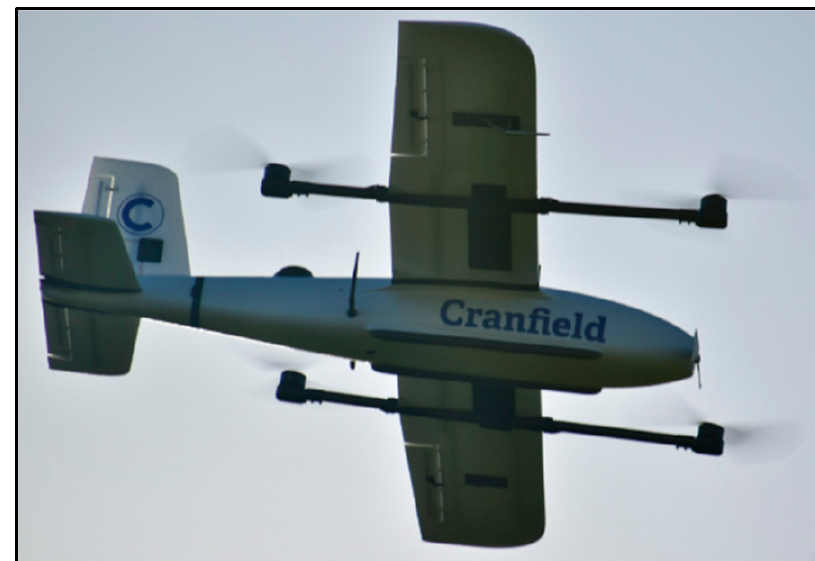
Figure 1. Image of the SWIFT aircraft in forward flight mode. Table 1. Details of SWIFT geometry.